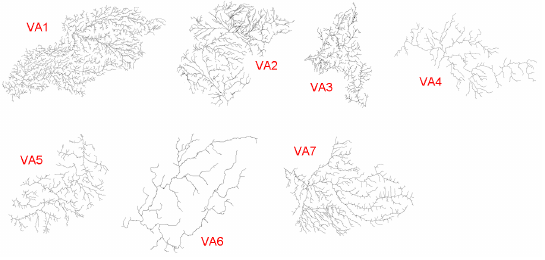
Figure A3. Drainage networks extracted from Valdivia basin.